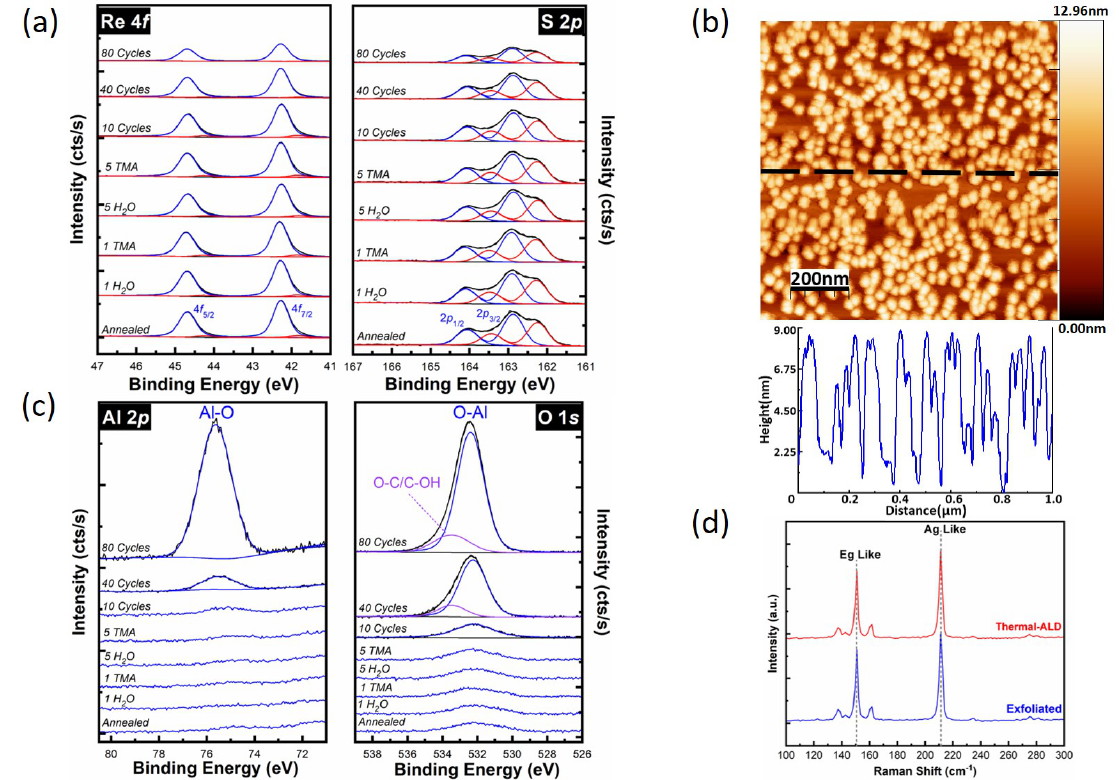
Figure 2. Thermal atomic layer deposition (ALD) of Al 2 O 3 on ReS 2 . ( a ) The evolution of Re 4 f and S 2 p core level spectra, ( b ) Ex-situ AFM image and line profile recorded following 80 cycles ALD of Al 2 O 3 , ( c ) Al 2 p and O 1 s core level spectra up to 80 cycles of Al 2 O 3 , and ( d ) Raman spectra comparison between exfoliated ReS 2 and following 80 cycles of ALD of Al 2 O 3